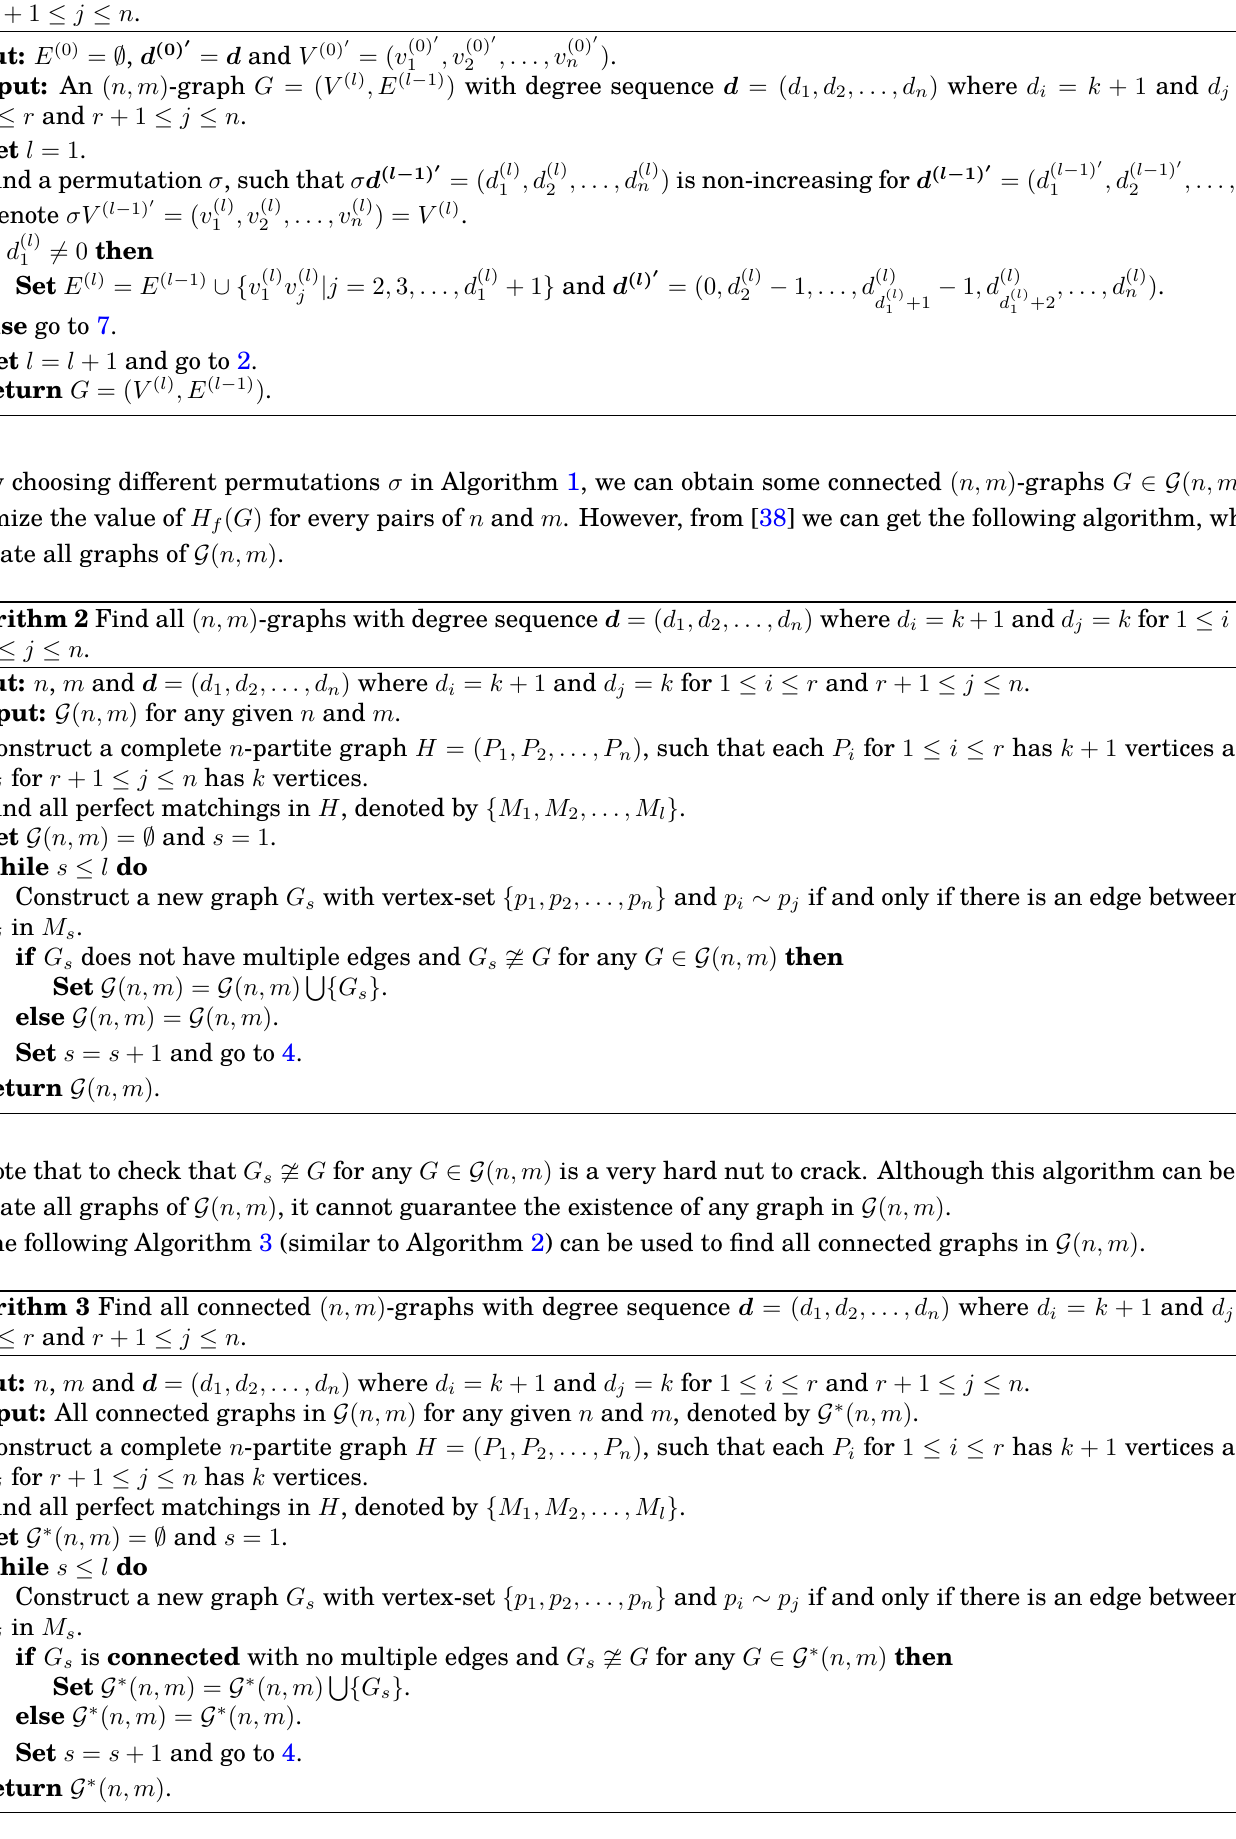
Algorithm 1 Find an ( n, m ) -graph G with degree sequence d = ( d 1 , d 2 , . . . , d n ) where d i = k + 1 and d j = k for 1 ≤ i ≤ r and r + 1 ≤ j ≤ n .